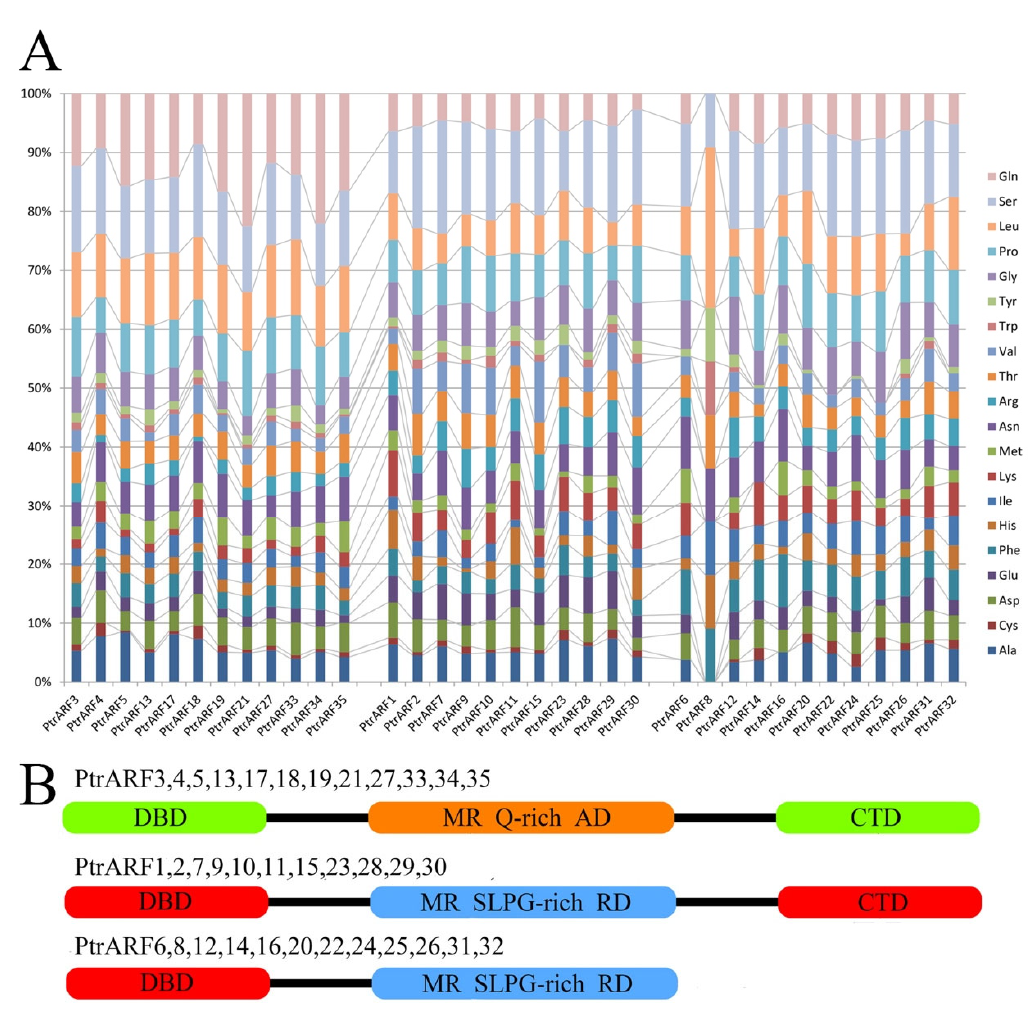
Figure 5. Amino acid compositions of middle region (MR) and classification of the PtrARF proteins. ( A ) Amino acid contents of the MR of 35 PtrARF proteins. PtrARF proteins are represented in the horizontal axis, and corresponding amino acids are represented in the vertical axis. Colored bars represent different amino acids; ( B ) the protein structure of PtrARF proteins. DBD, DNA-binding domain; CTD, C-terminal dimerization domain; MR, middle region; RD, repression domain; AD, activation domain; Q, glutamine; S, serine; L, leucine; P, proline; G, glycine.